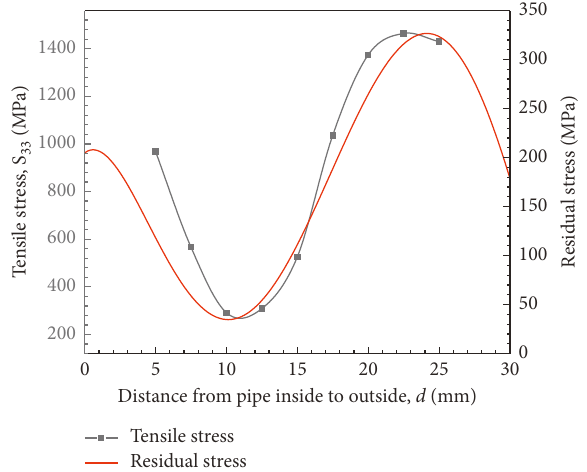
Figure 12: Tensile stress at crack apex ( θ � 90 ° ) with crack